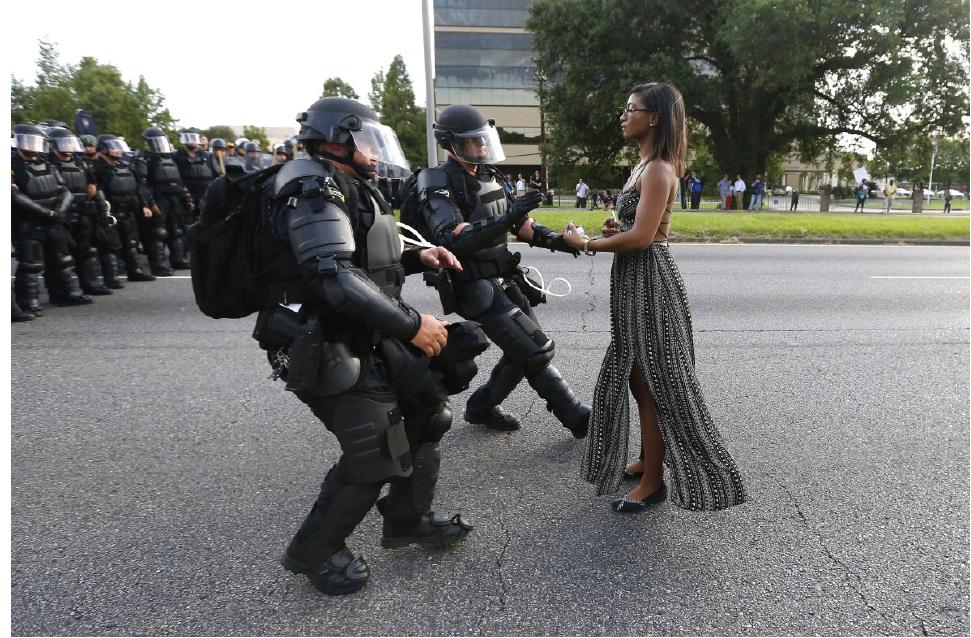
Figure 1. Arrest of Ieshia Evans at a Black Lives Matter rally in Baton Rouge, Louisiana, on 9 July 2016. Photograph by Jonathan Bachman (Reuters).